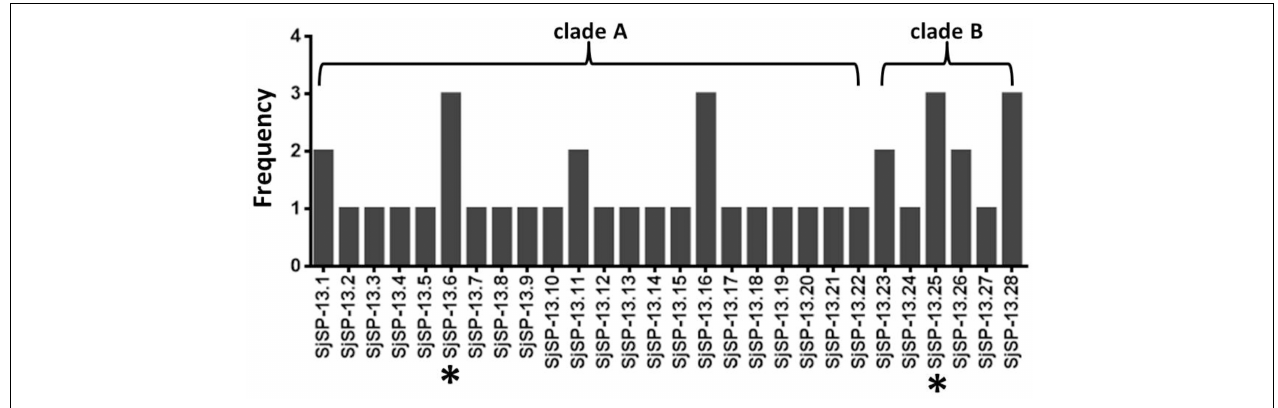
FIGURE 1 | Allele frequency of 28 SjSP-13 alleles. ∗ The representative alleles of SjSP-13 (SjSP-13.6 and SjSP-13.25) were selected for gene expression.